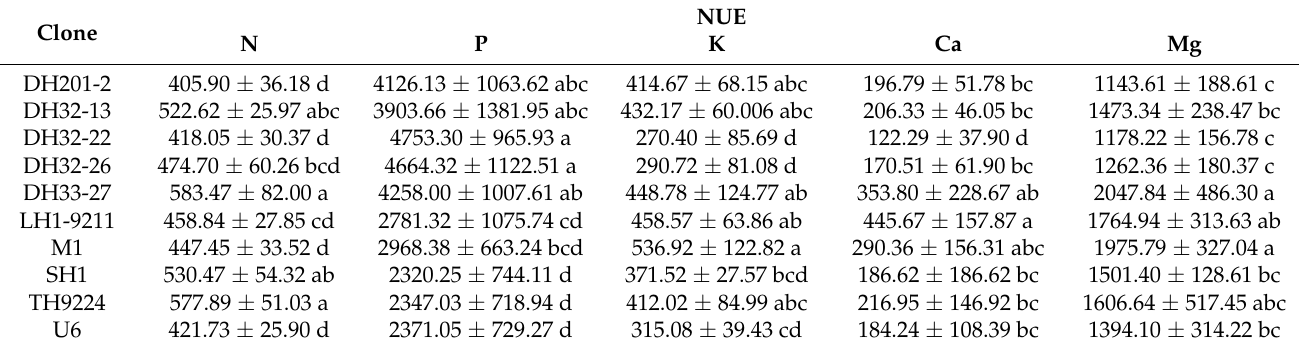
Table 4. Nutrient use efficiency for ten Eucalyptus